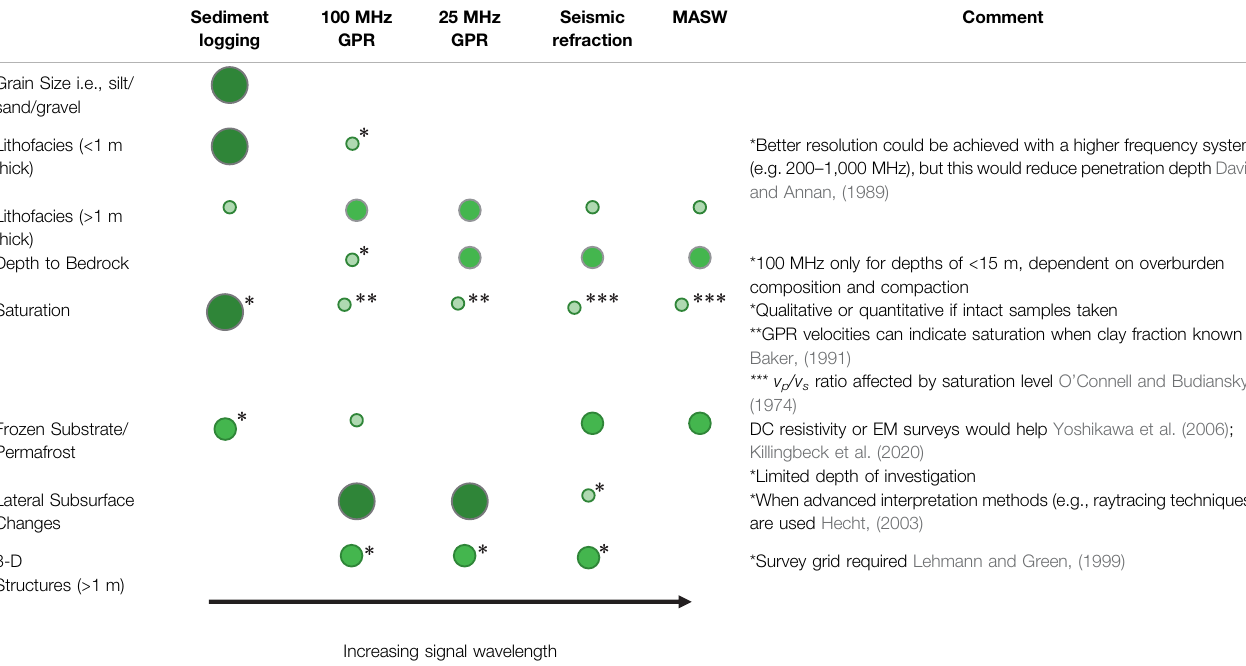
TABLE 2 | A summary of which techniques are suggested for providing information on typical proglacial investigation